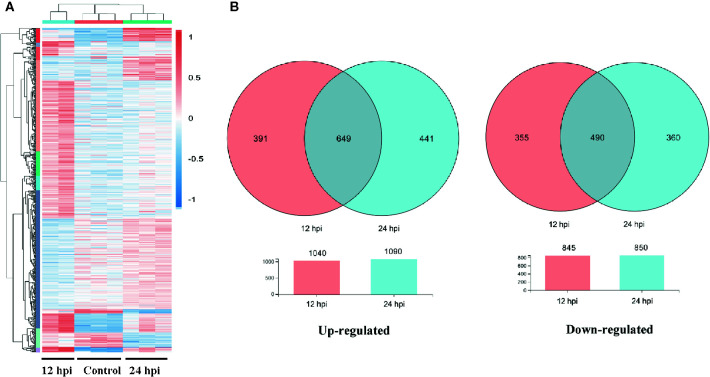
The differentially expressed gene (DEG) analysis at different time post infection with Gram-negative bacteria (P < 0.001). (A) A heatmap was used to classify the DEG expression patterns in all groups, the X-axis represents the time (h) post infection. (B) Venn diagrams of DEGs in 12 and 24 h groups. Left panel: up-regulated genes; right panel: down-regulated genes.